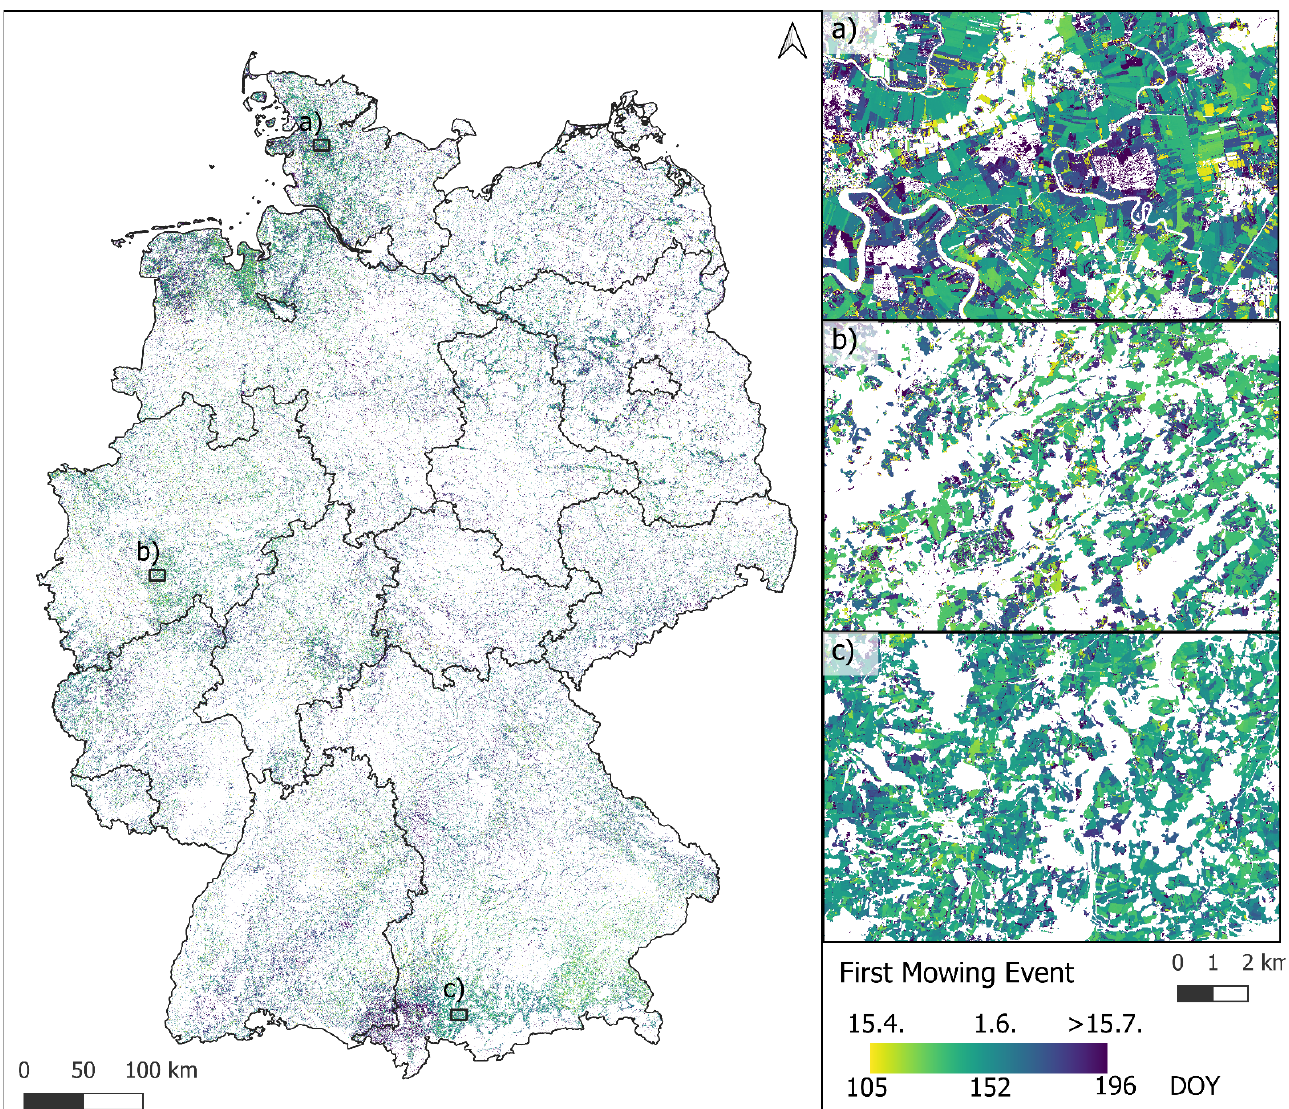
Figure 12. First mowing event on grassland in 2019 with a spatial resolution of 10 m with the EVI-based detection for Germany and for three zoom regions (a, b, c) indicated on the map.